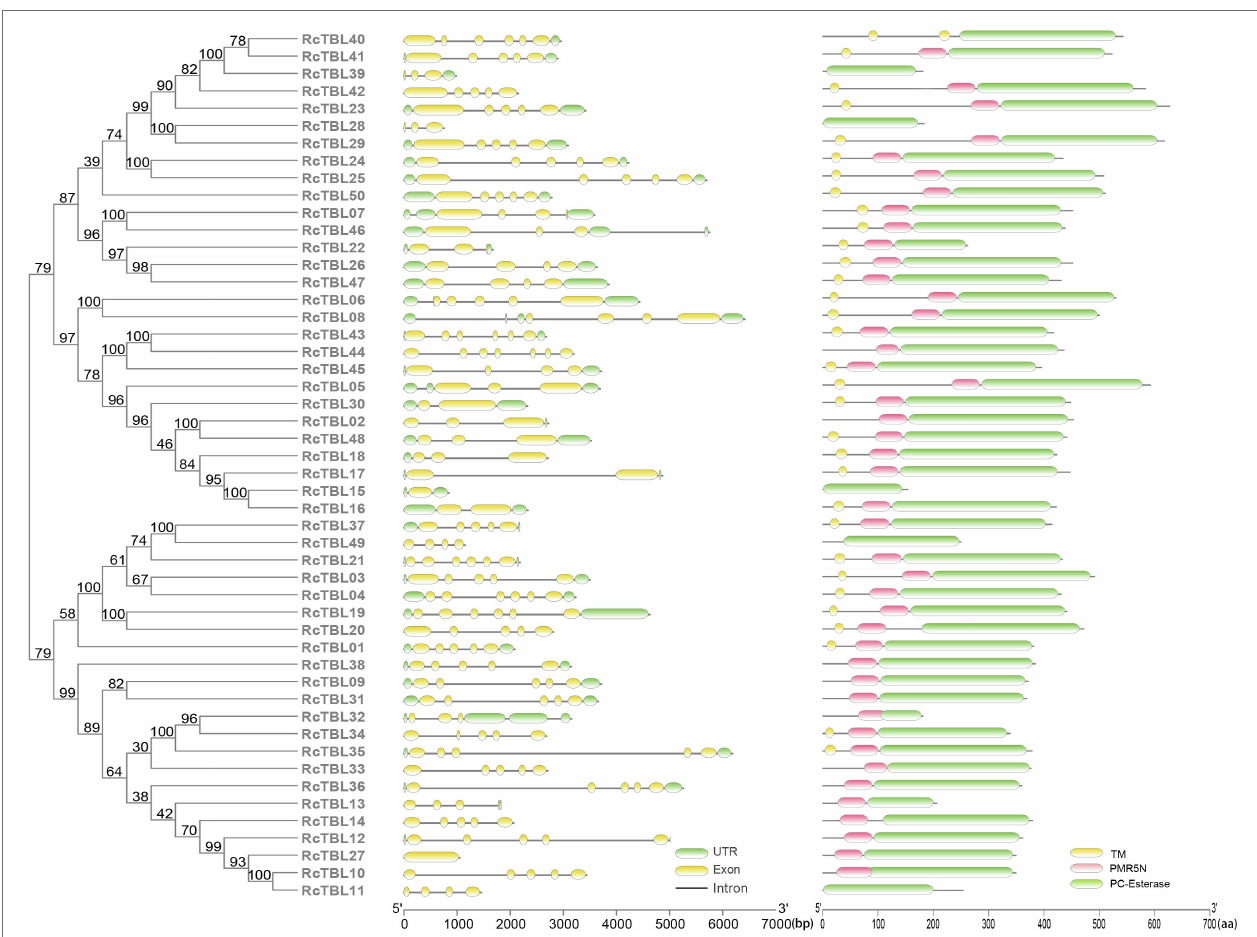
FIGURE 4 | Phylogenetic analyses and gene structures of rose TBL proteins. Complete alignments of all rose TBL proteins were used to construct a phylogenetic tree using the maximum likelihood method. The bootstrap values are indicated on the nodes of the branches. Exon–intron structure of RcTBLs is shown in the middle part of the figure, and the green boxes, yellow boxes, and gray lines represent UTRs, exons, and introns, respectively. Transmembrane and conserved domain of RcTBLs are displayed in the right part of the figure, and the green boxes, yellow boxes, and pink boxes represent PC-Esterase domain, transmembrane domain, and PMR5N domain, respectively. The scale on the bottom is provided as a